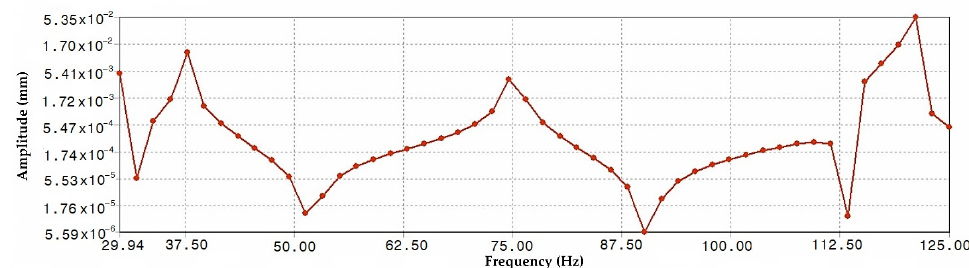
Figure 18. Frequency analysis of the designed E3-cycle frame.